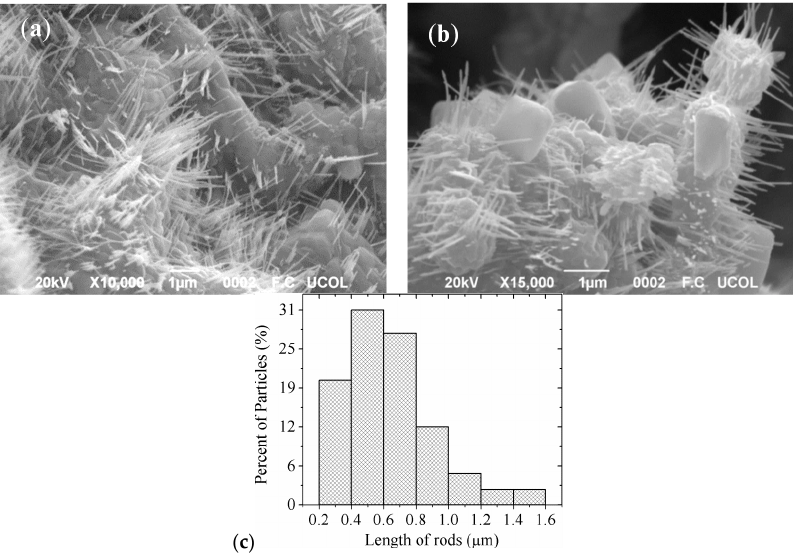
Figure 3. SEM images of MgSb 2 O 6 powders calcined at 800 °C at different magnifications: ( a ) 10,000×; ( b ) 15,000×; and ( c ) size distribution of the rods.